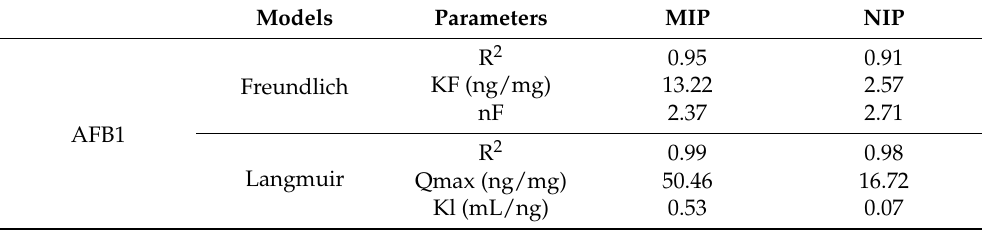
Table 1. Adsorption isotherms parameters obtained for AFs onto MIP and NIP.